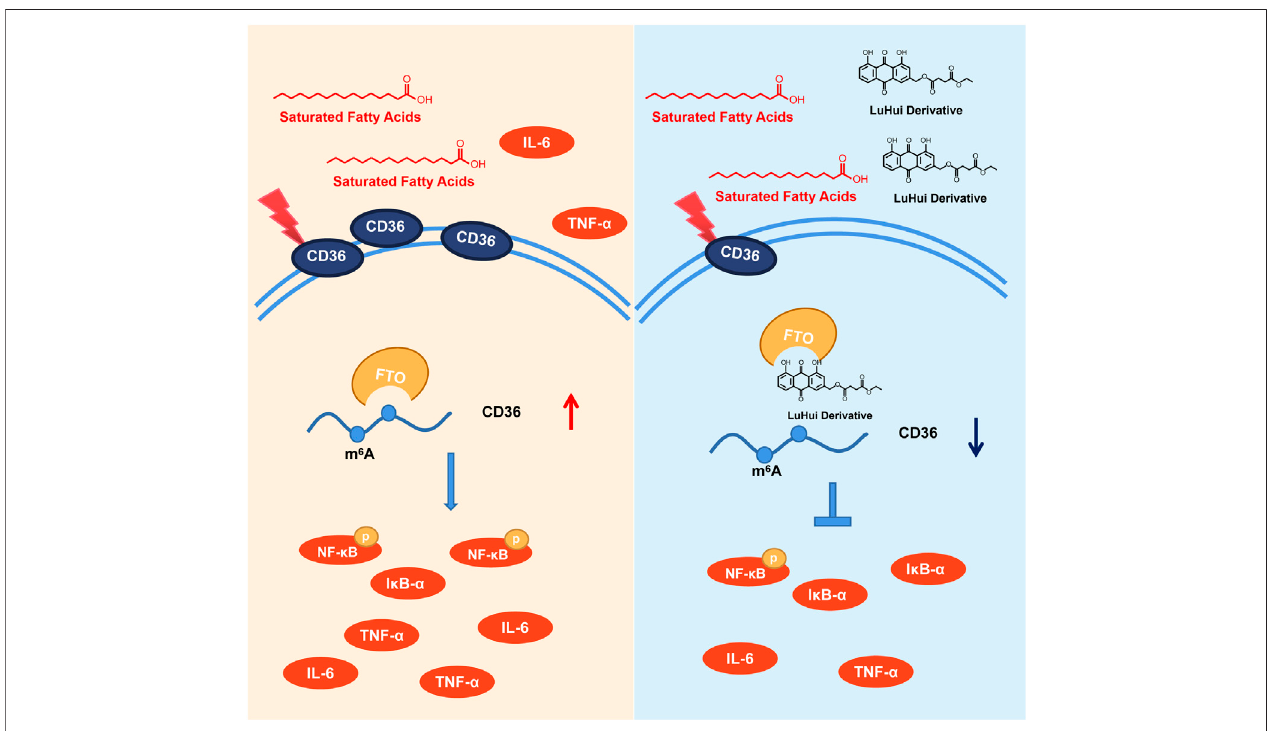
FIGURE 7 | Underlying mechanisms of the protective effect of LHD against hyperlipidemia-induced cardiomyocyte in fl ammation.